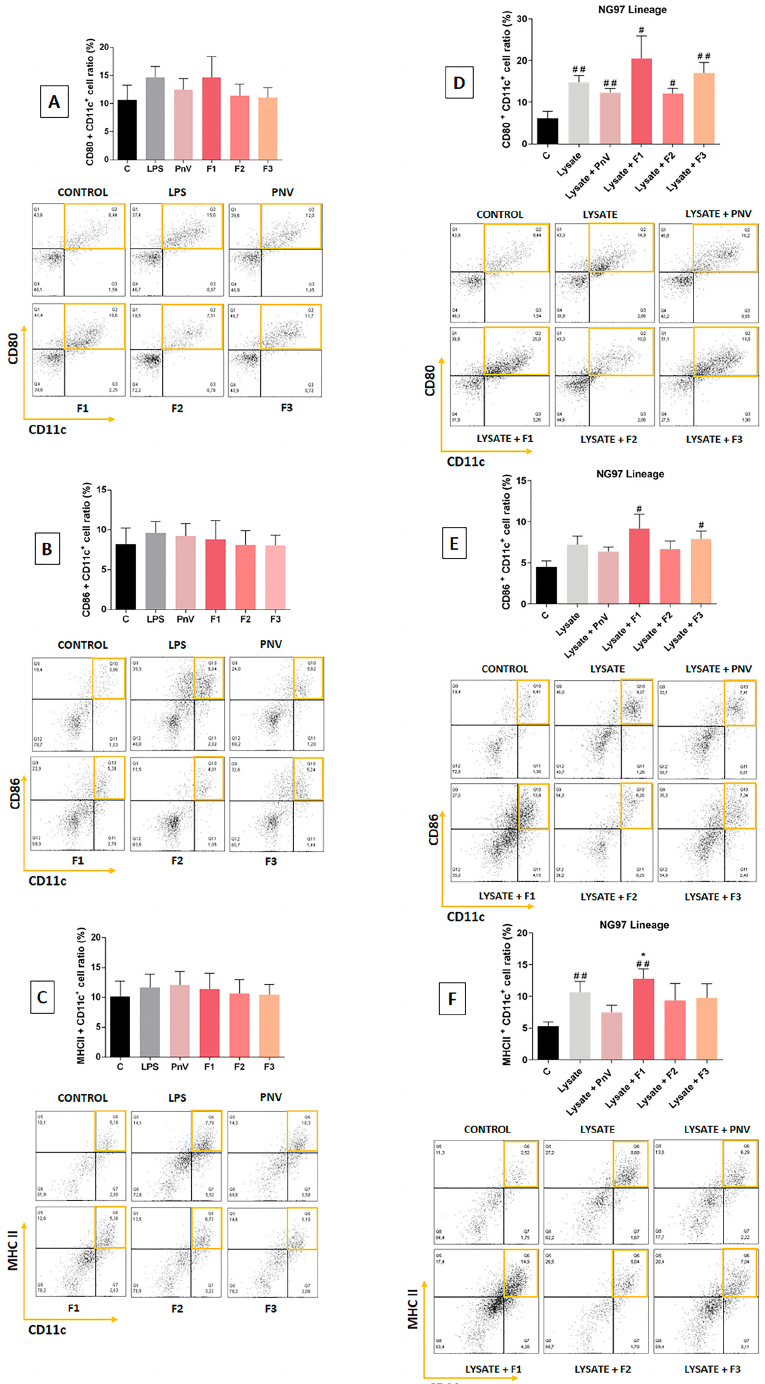
Figure 3. Flow cytometry of DC surface markers. Percentage of DCs expressing the surface markers CD80, CD11c, CD86 and MHC II in vitro. Cells were stimulated with LPS, PnV (14 µ g/mL) or fractions (1.0 µ g/mL) for 24 h ( A – C ). Graphs ( D – F ) show the markers in DCs stimulated with glioblastoma cells (NG97) lysate and simultaneously treated with PnV (14 µ g/mL) or fractions (1.0 µ g/mL) for 24 h. The panels behind the graphs show representative double positive gates of each group. Data were analyzed by one-way ANOVA and Kruskal–Wallis test, presented as mean ± standard error (SEM). Unpaired Student’s t -test was used to compare each treatment with the control. # p < 0.05, ## p < 0.01 compared to the untreated control; * p < 0.05 compared to the lysate plus PnV group. Results of three independent